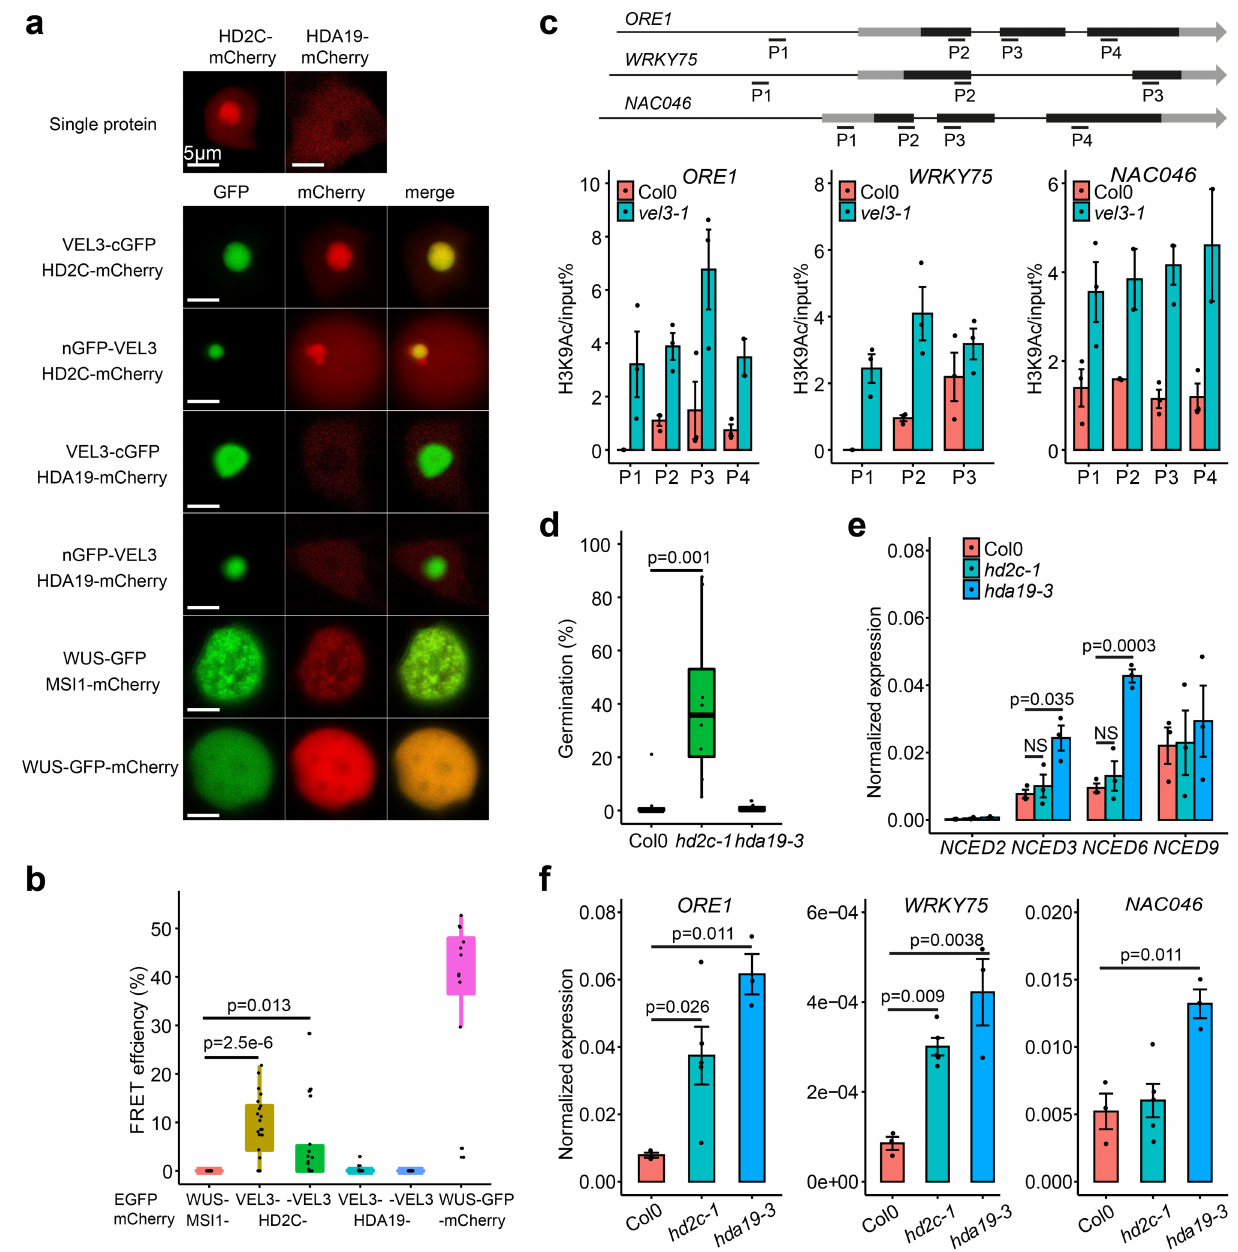
Fig. 6 | VEL3 is required for the function of histone deacetylase complexes in the endosperm regulating seed dormancy. a VEL3 co-localizes with HD2C in the nucleolus, but not with HDA19, which exists pre-dominantly in the nucleoplasm during transient expression in Nicotiana . b FRET assays show that VEL3 and HD2C associate inplanta . VEL3-: VEL3 C-terminal GFP fusion. -VEL3: VEL3 N-terminal GFP fusion. Self-dimerizing WUS-GFP/mCHERRY is shown as the positive control. Box- plots indicate minimum and maximum values, as well as 25th, 50th, and 75th quartiles. p -values are derived from the two-sided t -test. Sample sizes are included in source data ( N =16,21,18,16,16,12 from left to right). The experiments were repeated twice. c VEL3 is required for H3K9 deacetylation at ORE1 , WRKY75 and NAC046 . Gene models show location of exons in black and primers used for ChIP. ChartsshowH3K9Aclevelsinmatureendospermsofseedssetat16°C.Datashown